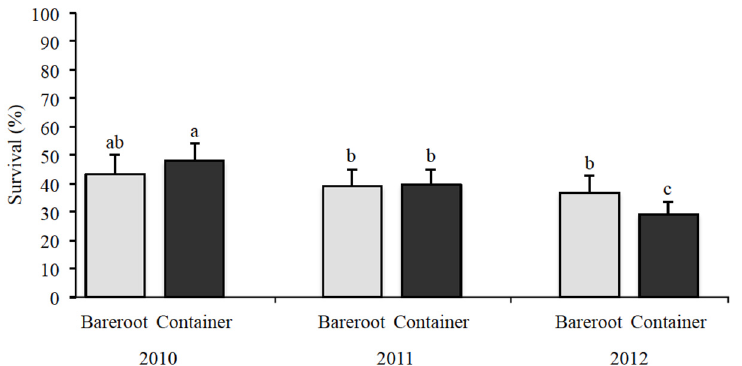
Figure 3. Mean survival with standard error after the first (2010), second (2011) and third (2012) growing season by seedling type. Lowercase letters indicate significant differences in survival between seedling